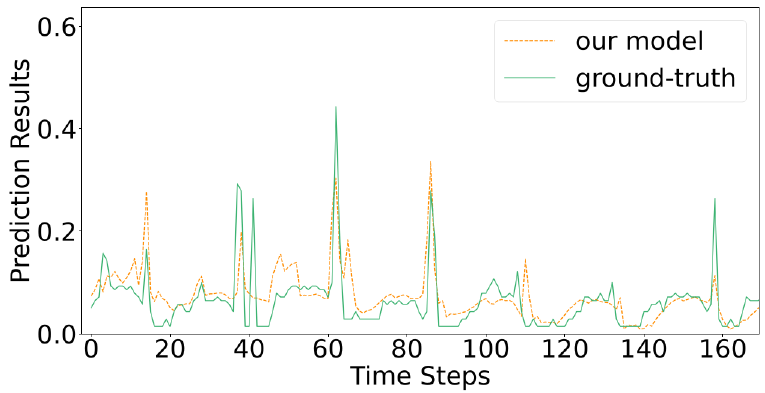
Figure 10. Electricity (Horizon = 24) forecast results.